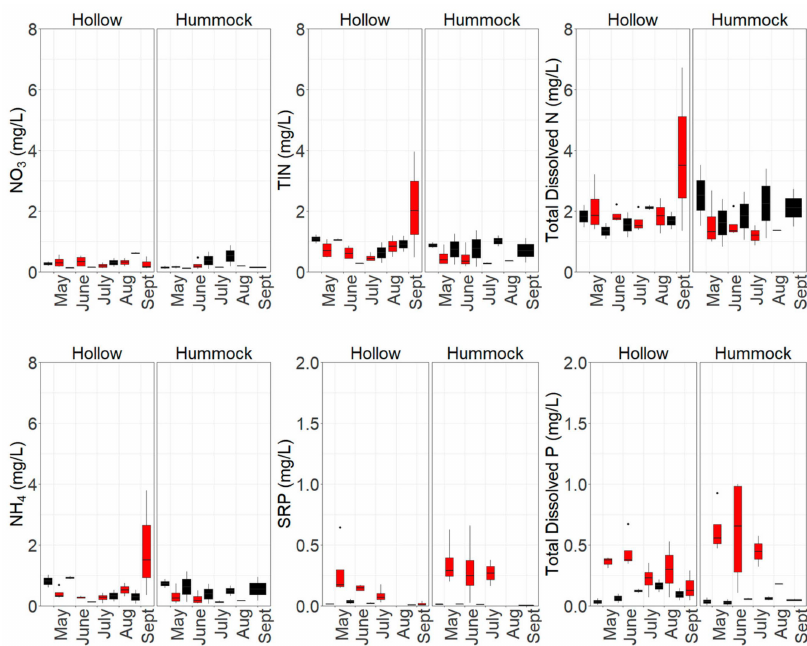
Figure 3. Groundwater nutrient concentrations over the growing season, comparing the Unburned (red) and Burned (black) areas and the microtopographical di ff erences observed. + Extractable NH 4 concentrations decreased significantly ( p < 0.01) over the season in